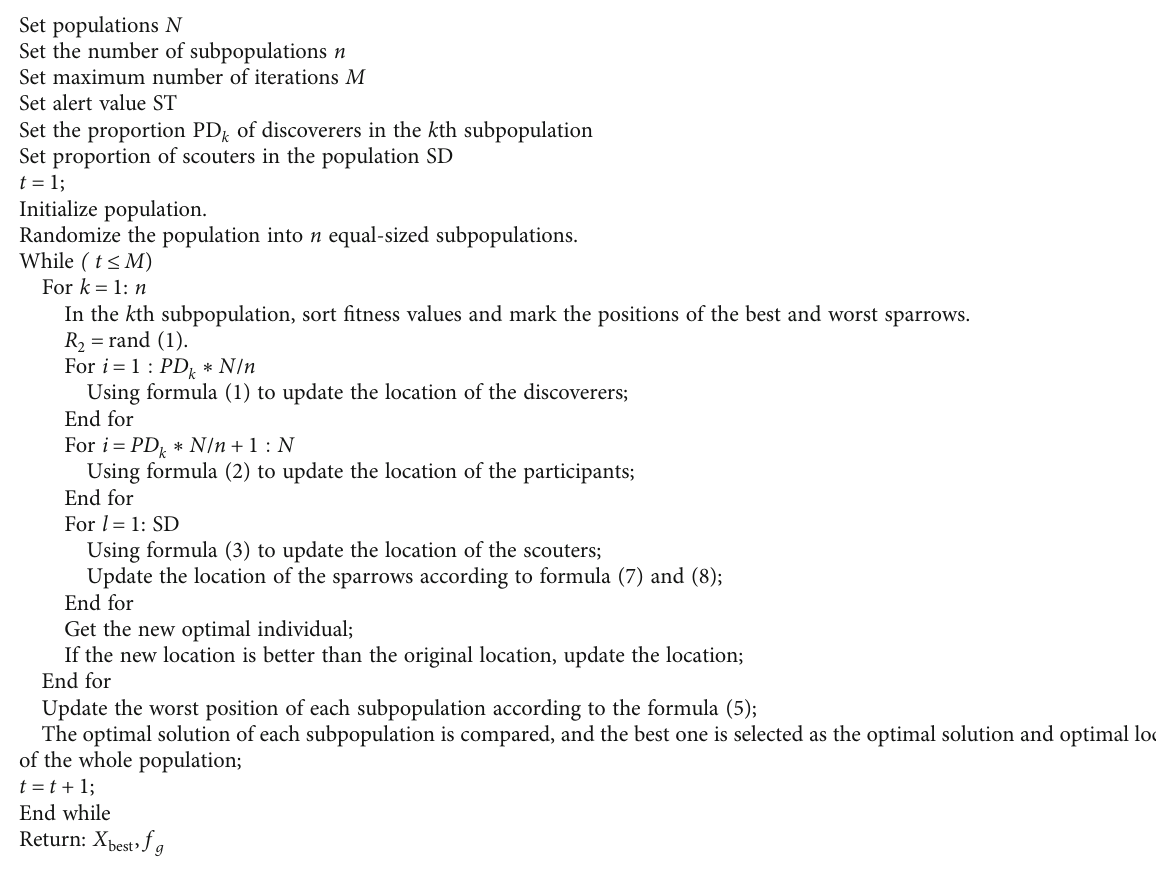
Algorithm 1: The framework of the